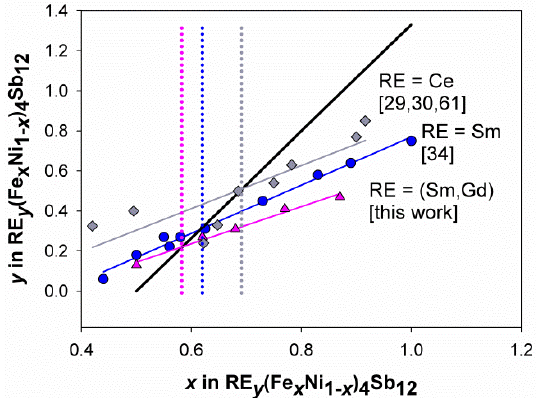
Figure 4. The rare earth content as a function of the Fe amount in different (Fe-Ni)-based skutterudites. The black thick line represents the theoretical amount of trivalent rare earth necessary to reproduce the electronic count of the compensated semiconductor CoSb 3 ; experimental values (deriving from this work and from references [29,30,34,61] are fitted by regression lines. The dotted vertical lines pinpoint the position of the p/n crossover for the different systems.